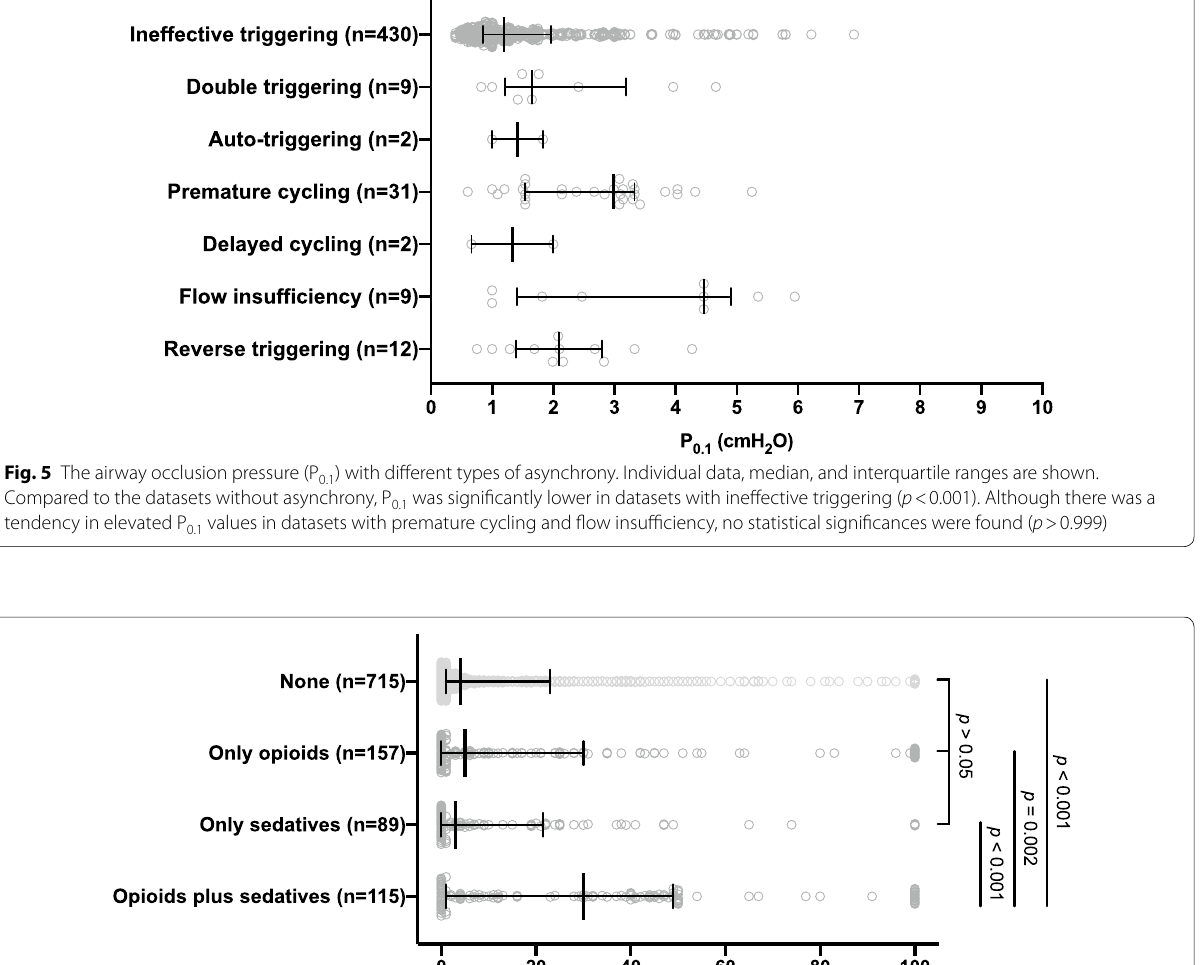
tional file 1: Table S3).